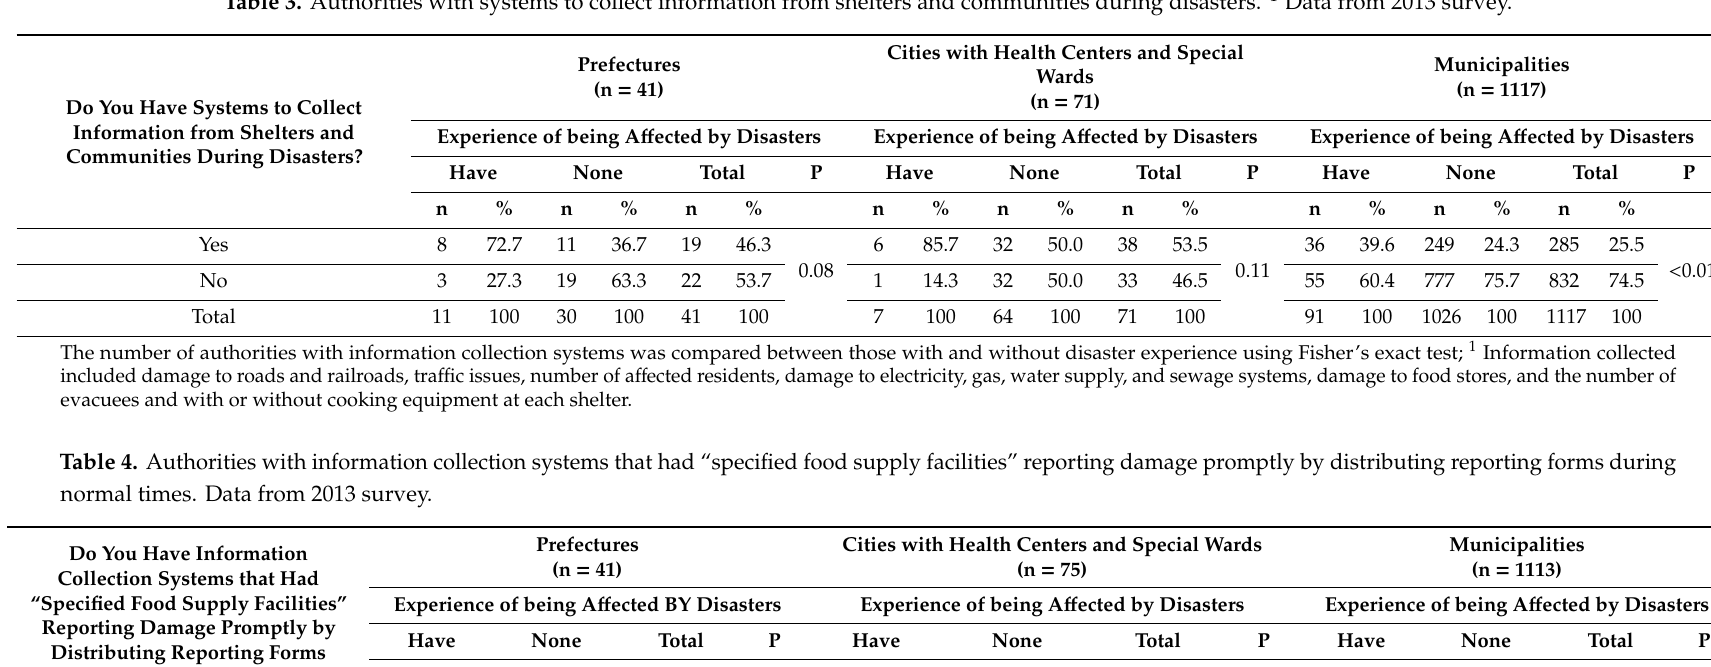
Table 3. Authorities with systems to collect information from shelters and communities during disasters. 1 Data from 2013 survey.